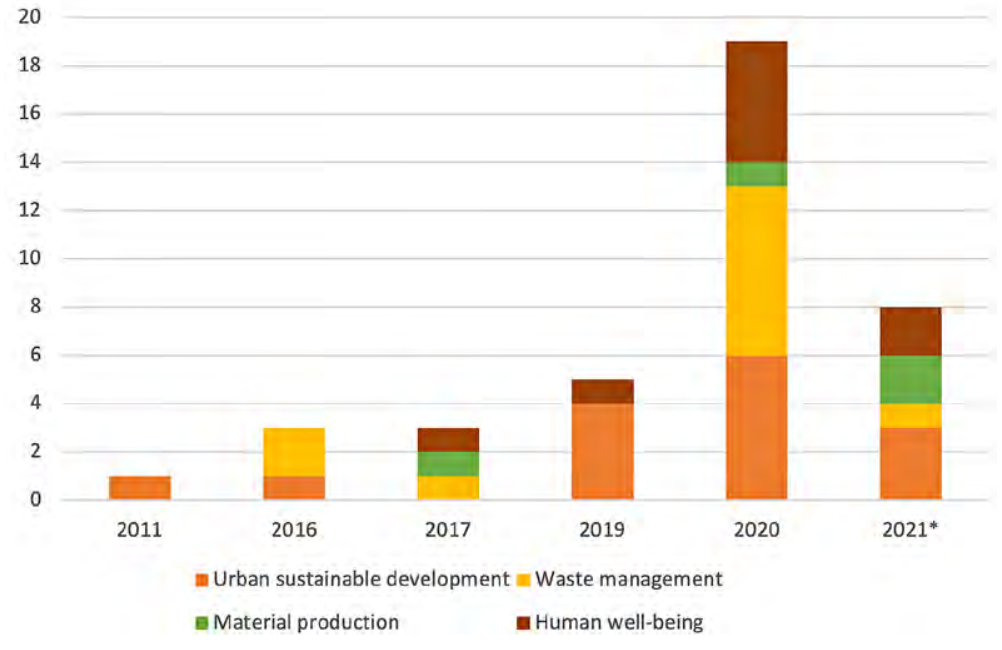
Figure 2. Distribution of research papers and studies included in